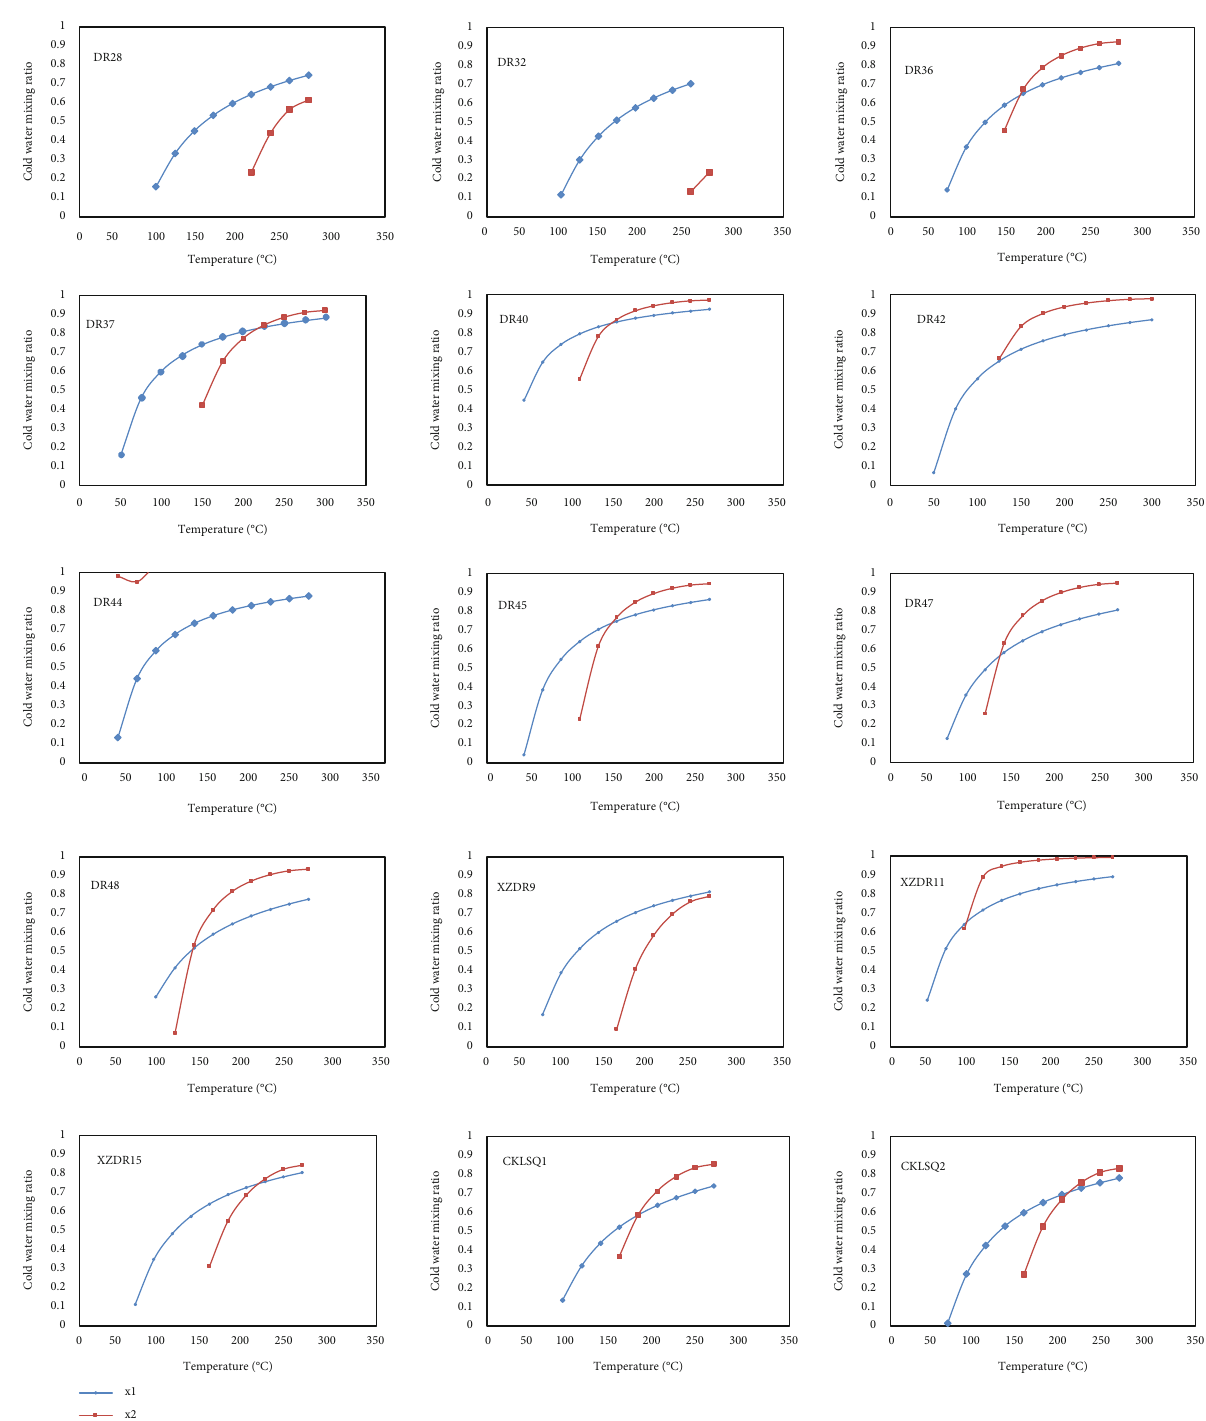
Figure 9: Si-enthalpy model of the study